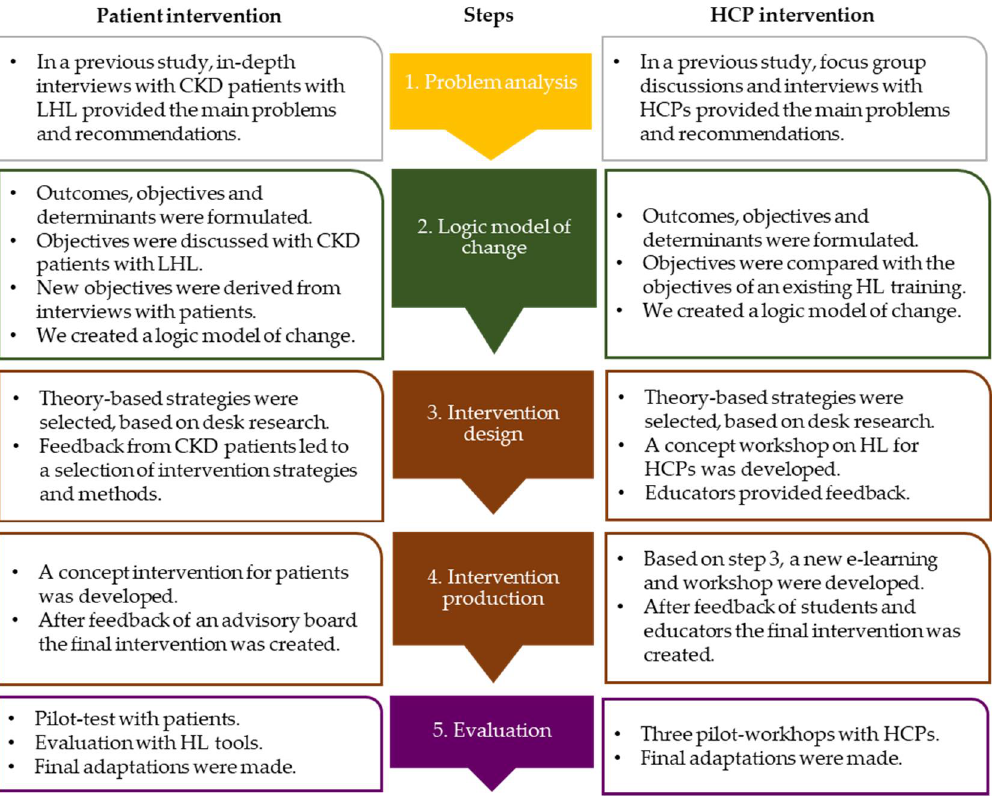
Figure 1. The Intervention Mapping process to develop an intervention for both kidney patients with limited health literacy and health care professionals. CKD = chronic kidney disease, HCP = health care professional, HL = health literacy, LHL = limited health literacy.